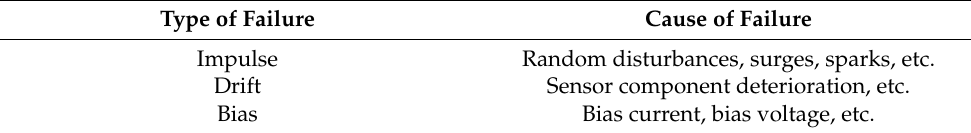
Table 1. Typical sensor